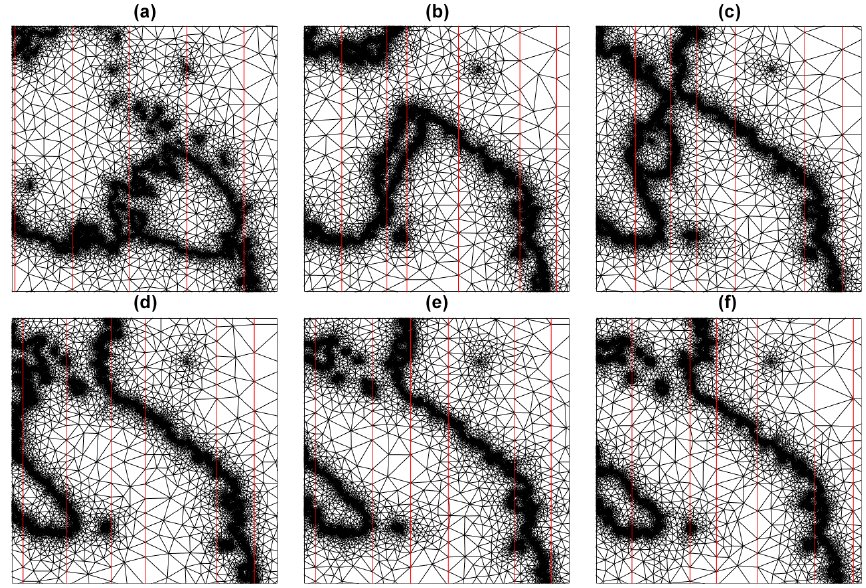
Figure E3. The meshes of the Antarctic retreat simulation shown in Fig. 11, zoomed in on the Ross Ice Shelf. The retreat of the ice sheet is clearly visible in the mesh structure, as are the processor domains resulting from the load-balanced domain subdivision (borders highlighted in